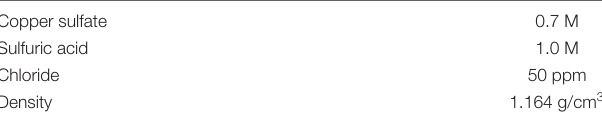
TABLE 1 | Electroplating bath compositions and physical characteristics.